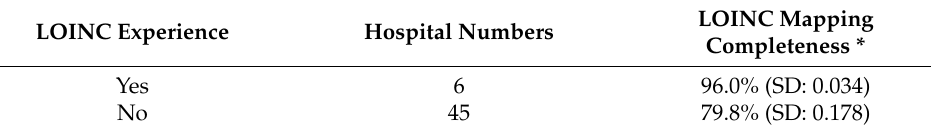
Table 3. Rate of LOINC mapping completeness based on